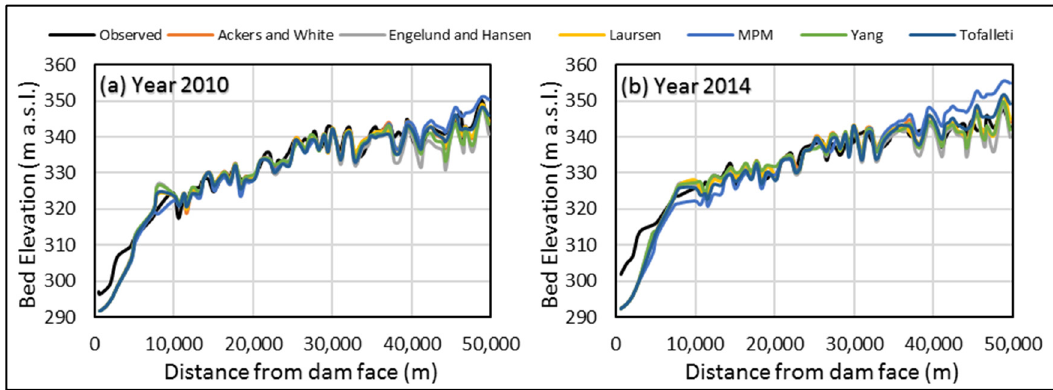
Figure 11. Comparison of observed and simulated bed elevation for different sediment transport functions.